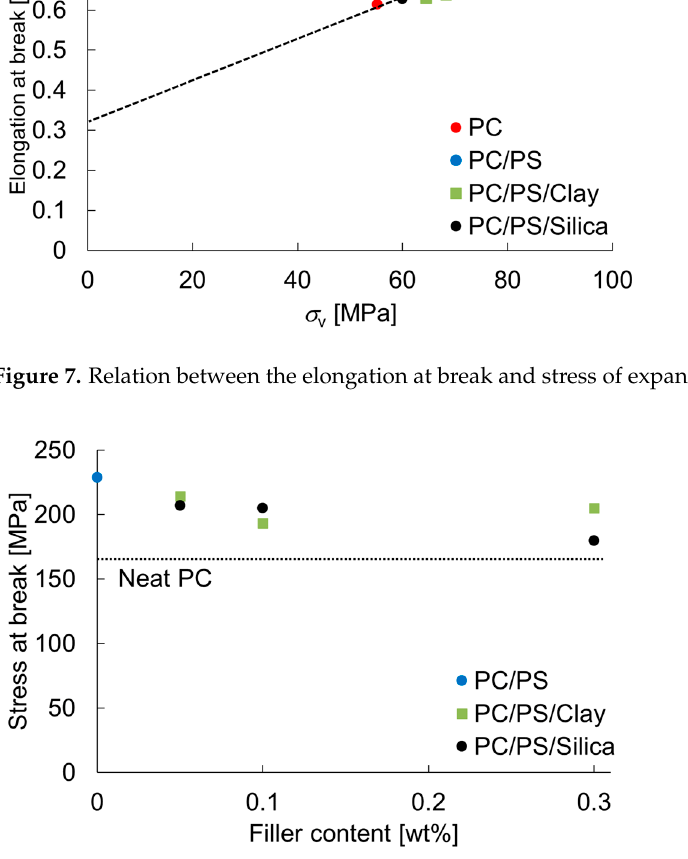
Figure 8. Nano-filler content dependence of the stress at break.